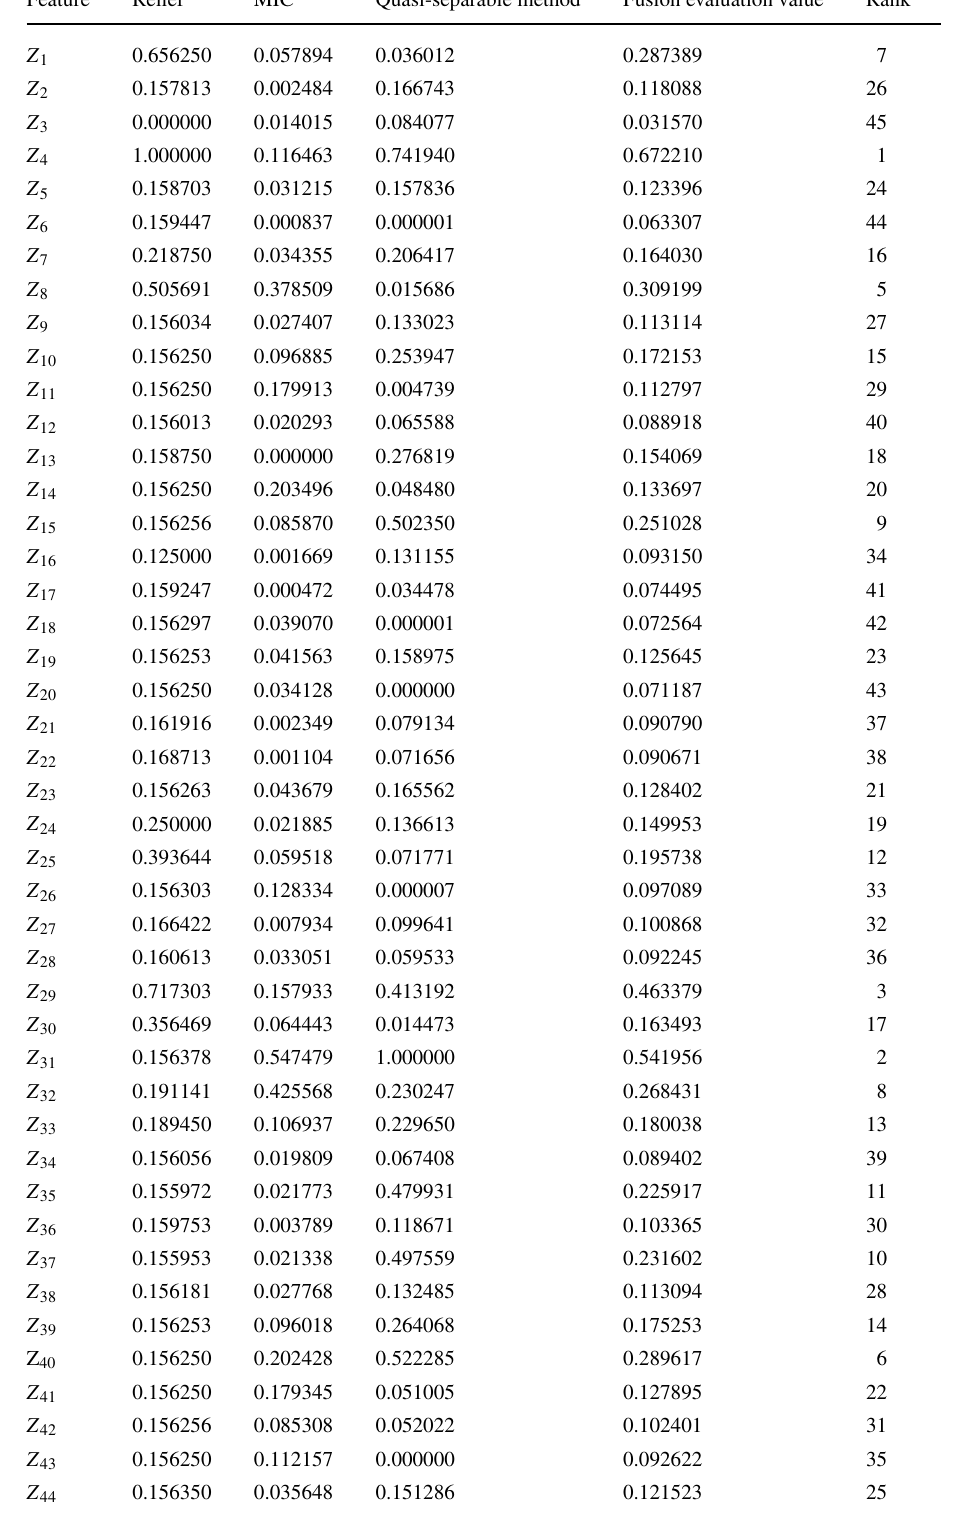
Table 8 Comprehensive ranking of 45 preliminary